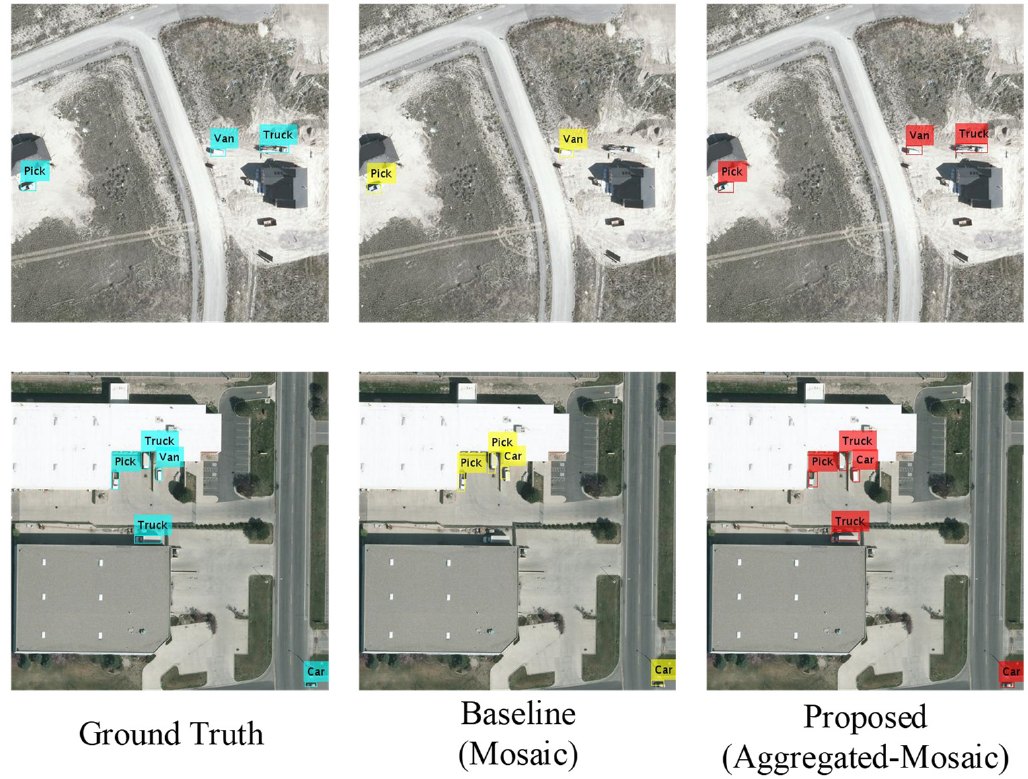
Figure 12. Detection result: Ground Truth (right), Mosaic (middle), Aggregated-Mosaic (left). Table 2. Results of VEDAI 512.